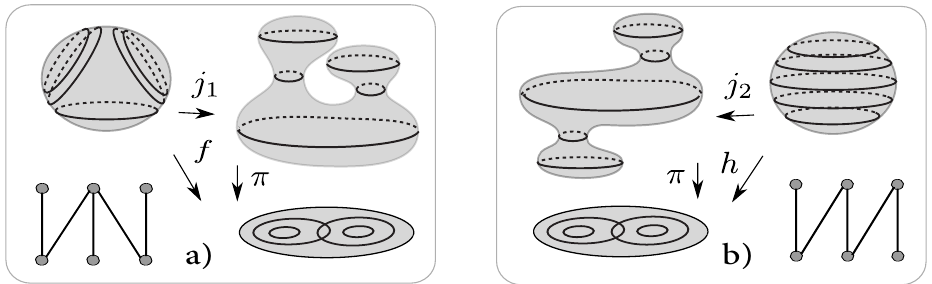
Figure 3. Examples of fold that are images of different maps with zero degree (see [13]) and equal apparent contours: ( a ) are two fold maps from S 2 into the plane; ( b ) corresponds with two fold maps from torus into the